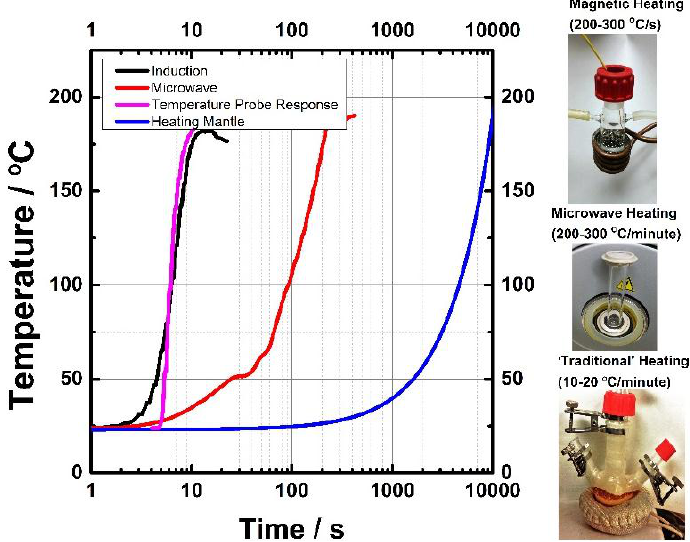
Figure 2. Typical heating rates of magnetic, microwave and traditional heating methods. The heating rates depend on the power absorbed by the reaction mixture or contents.